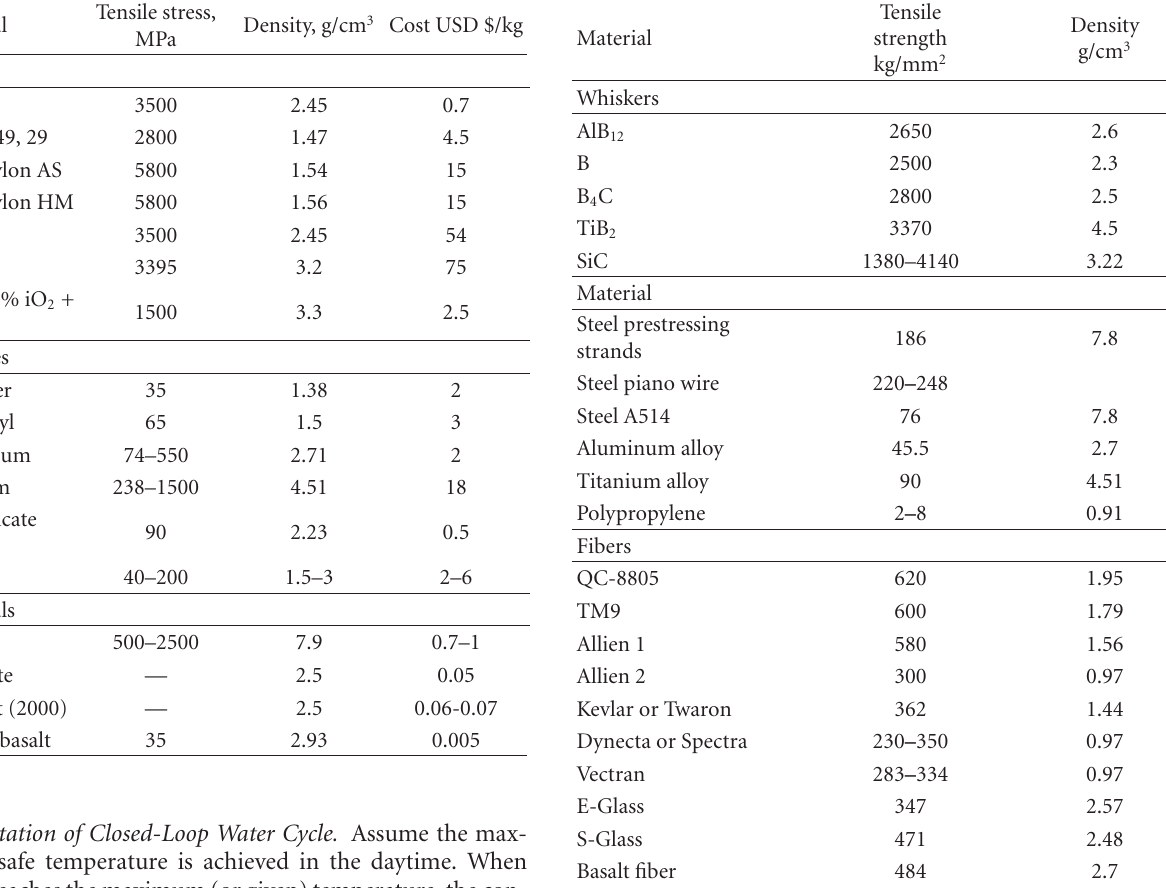
Table 3: Average cost of material (2005–2007). Table 4: Material